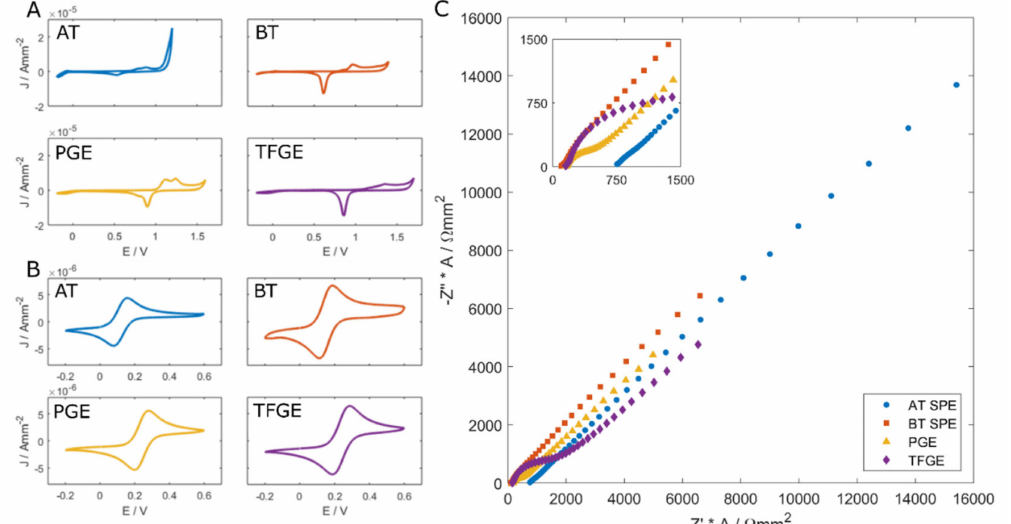
Figure 2. ( A ) Characterisation of clean polycrystalline gold electrode (PGE), thin-film gold electrode (TFGE) and clean AT and BT screen-printed electrodes (SPE). 0.1M H 2 SO 4 CV cleaning responses. ( B ) CV and ( C ) impedance performed in 2 mM Fe[CN] 63 − /Fe[CN] 64 − + 50 mM PB + 200 mM KCl. ( C ) Inset: Close up of high frequency impedance